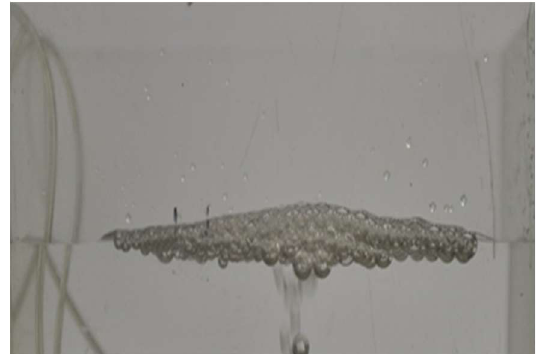
Figure 5. Examples of air bubble images for 4.62 mmol/dm 3 C 4 E 2 .